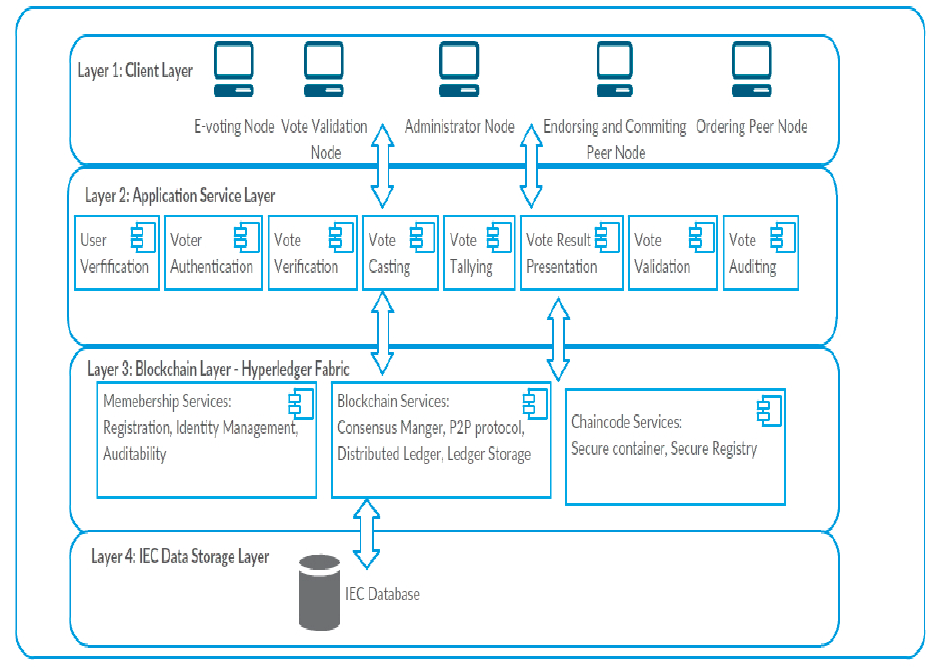
Figure 1. A schematic view of the blockchain-based architecture for national e-voting system (BANES).